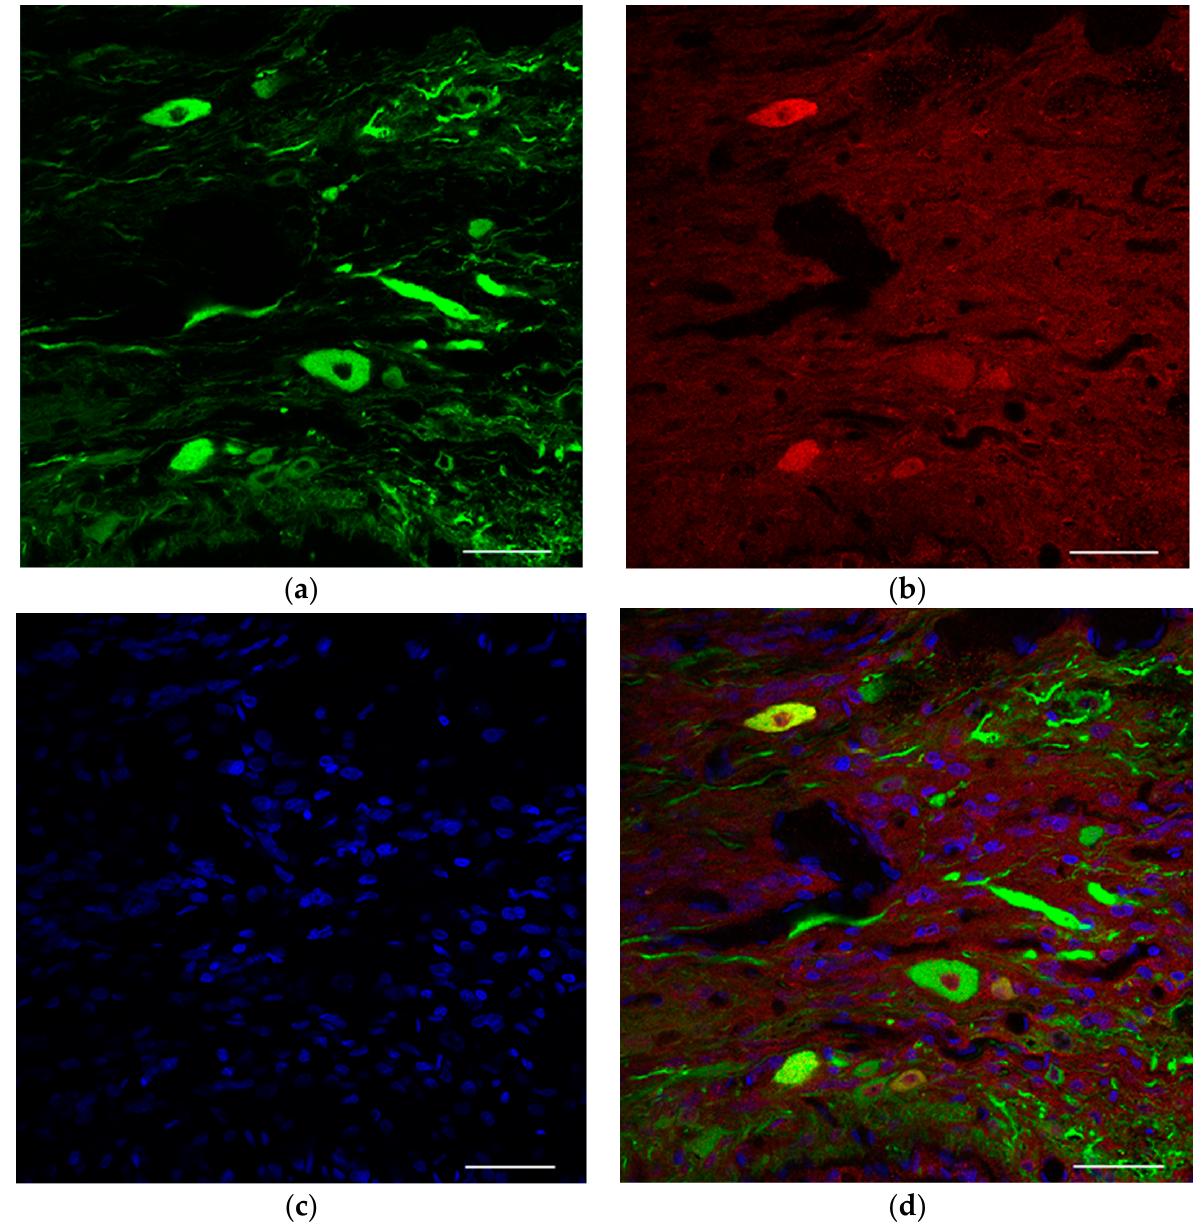
Figure 3. Immunohistological analysis of survival-engrafted neuron at the end of the distal peripheral nerve (sagittal section). ( a ) Tuj1 ( β 3 tubulin) staining. ( b ) ChAT (choline acetyltransferase) staining. ( c ) Hoechst staining. ( d ) Tuj1/ChAT/Hoechst staining. Scale bar = 50 µ m. Neuromuscular junctions in the reinnervated extensor digitorum longus